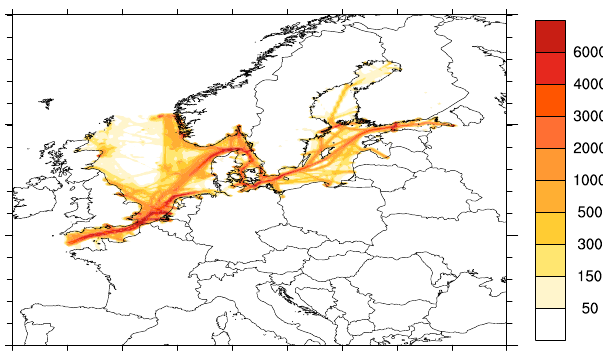
Figure 1. Ship emissions of SO x (mgm − 2 ) in the Baltic Sea and the North Sea in